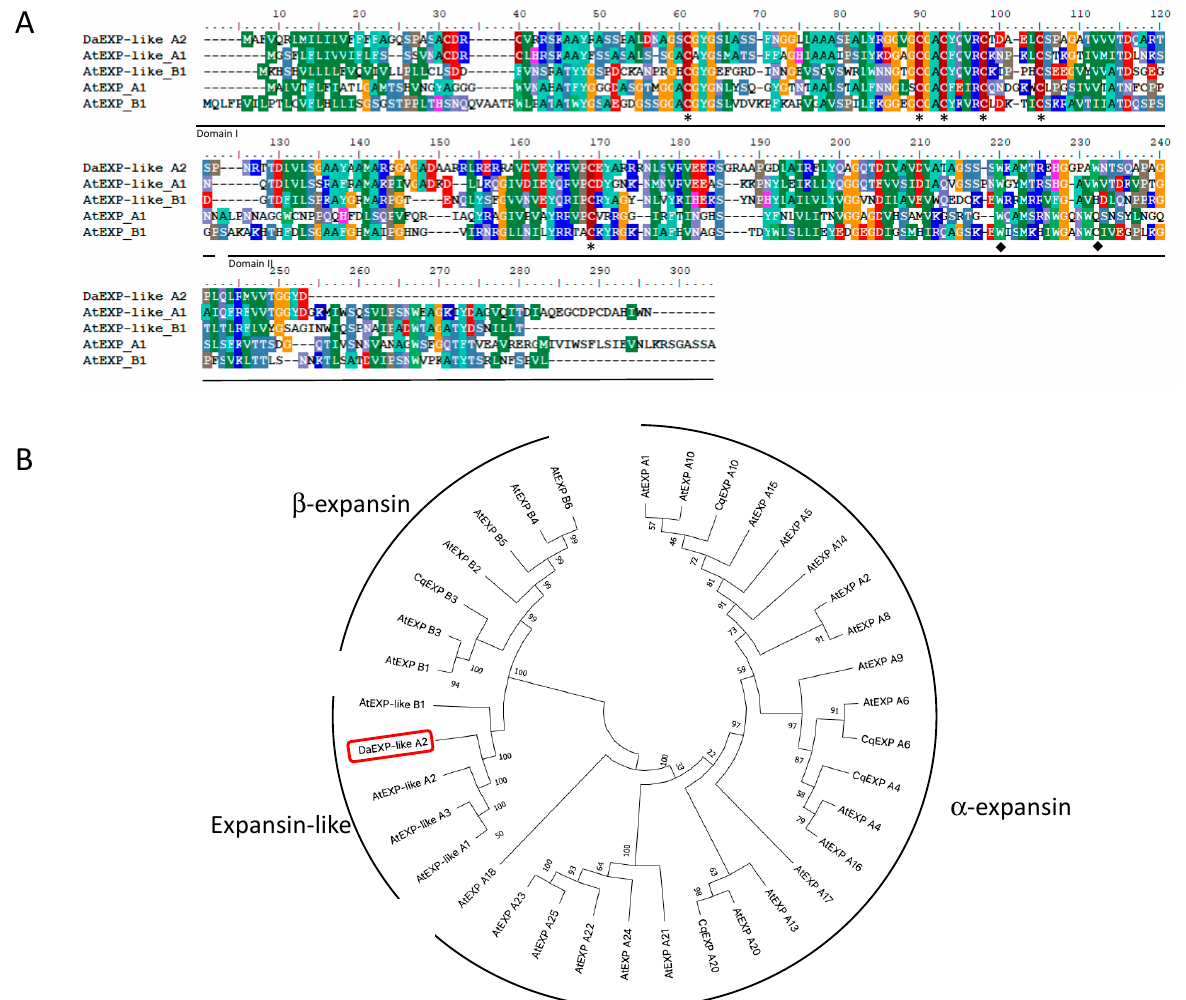
Figure 4. DaEXLA2 sequence analysis. ( A ) Multiple sequence alignment between different expansin proteins. Letters with the same color are identical residues or similar residues. Meanwhile, gaps are indicated by dashes. Asterisks show conserved Cys residues (C) of expansin proteins. Black diamonds indicate aromatic tryptophan residues (W) of expansins proteins. ( B ) Phylogenic analysis of the expansin from D. antarctica with the following different plant orthologs proteins: Arabidopsis thaliana AtEXPA1 (AEE34945), AtEXPA2 (AED90852), AtEXPA4 (AEC09708), AtEXPA5 (AEE77523),